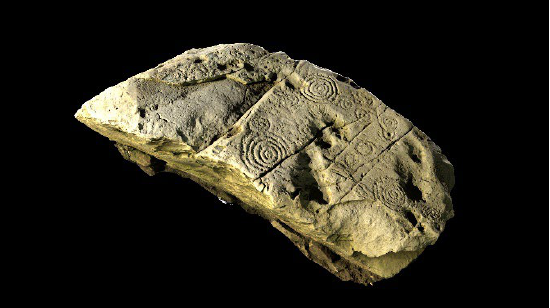
Figure 16. A rendered image of the K2 model generated in RealityCapture with calibrated colour photo texture and illumination to highlight artwork.